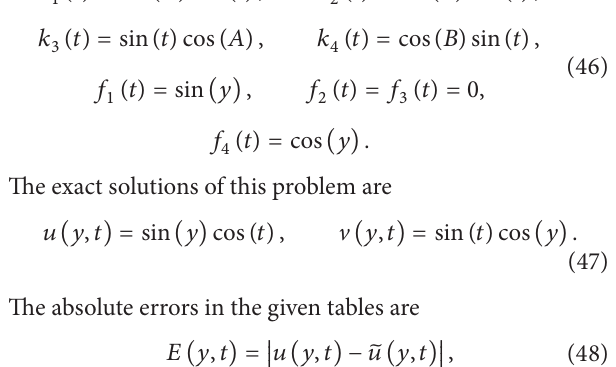
Figure1:Theapproximatesolution ̃𝑢 ofproblem(45),where 𝑁 = 16 and 𝛼 = 𝛽 = 0 in the interval [−𝜋,𝜋]